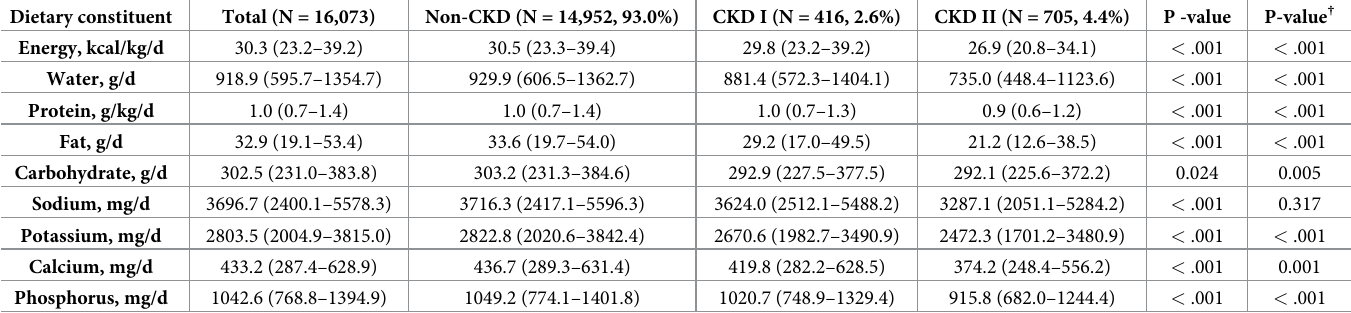
Table 3. Nutritional intake in non-CKD versus early CKD group �